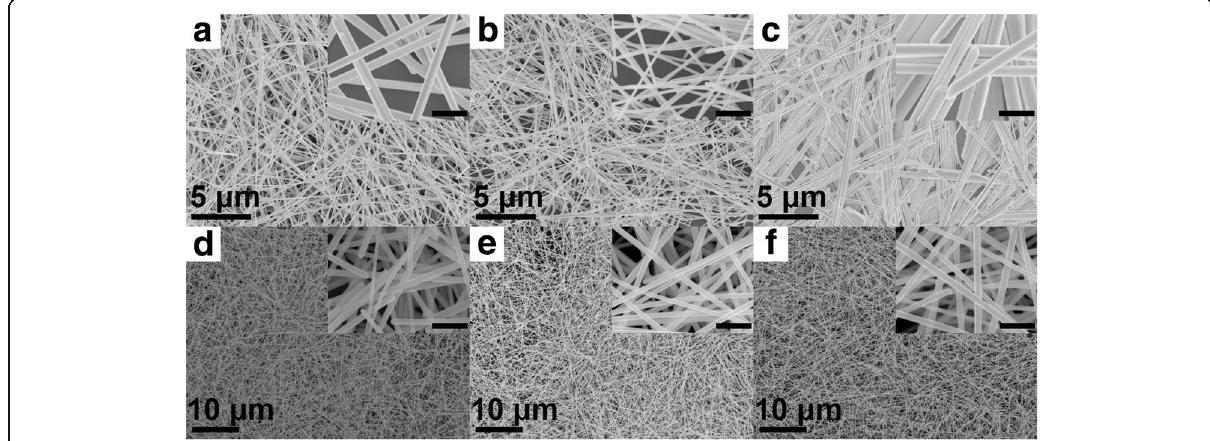
Fig. 2 SEM images of Ag NWs synthesized using different mixed PVP molecules. a PVP-40:PVP-58 = 2:1, b PVP-40:PVP-58 = 1:1, c PVP-40:PVP-58 = 1:2, d PVP-40:PVP-360 = 2:1, e PVP-40:PVP-360 = 1:1, f PVP-40:PVP-360 = 1:2, respectively. All the total concentration of PVP are 0.15 M, and different PVP molecules are mixed at molar ratio. (The insets in a – f are the corresponding SEM images with high magnification, and all the scale bars are 500